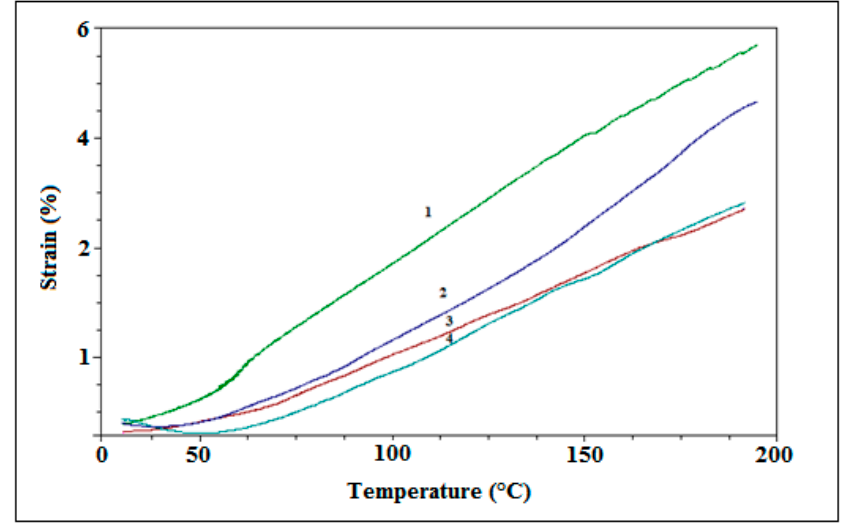
Figure 5. Strain-temperature of ( 1 ) pure PDMS; ( 2 ) 5% Fe-PDMS composite; ( 3 ) 10% Fe-PDMS composite; and ( 4 ) 15% Fe-PDMS composite. composite; and ( 4 ) 15% Fe-PDMS